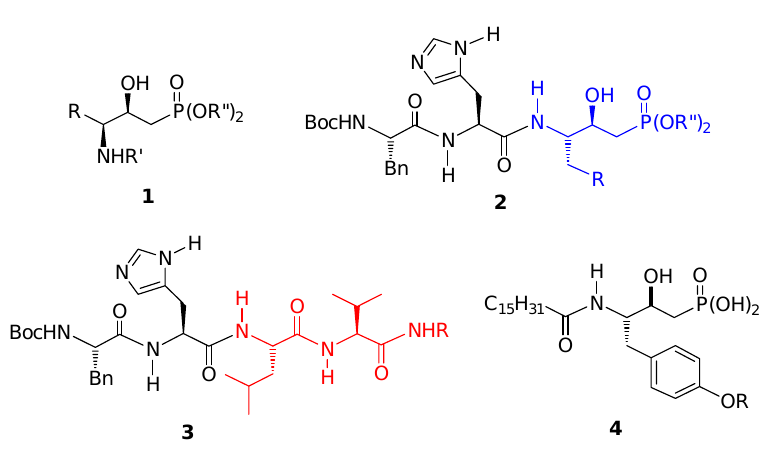
Figure 1. Structures of compounds 1–4